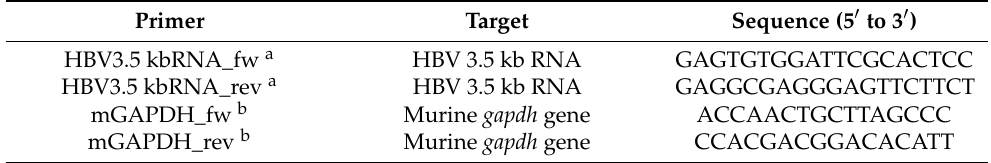
Table 1. Primers to quantify HBV